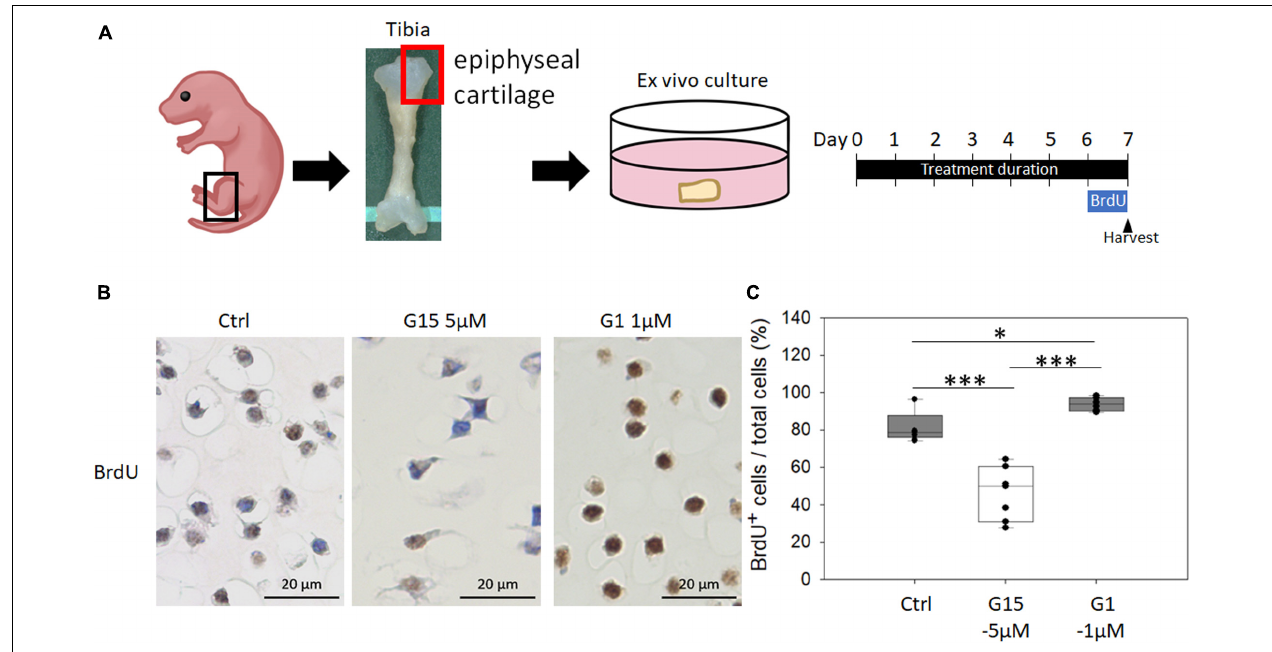
FIGURE 6 | Effects of GPER-1 agonist and antagonist treatment on chondrocyte proliferation in cultured epiphyseal cartilage. (A) Graphical depiction of procedures described using ex vivo epiphyseal cartilage. (B,C) Antagonist (G15) and agonist (G1) of GPER-1 were used to testing effect of GPER-1 mediation on cell proliferation by measuring number of BrdU-positive chondrocytes. Scale bars, 20 µ m. Each group, N = 5. ∗ P < 0.05, ∗∗∗ P <